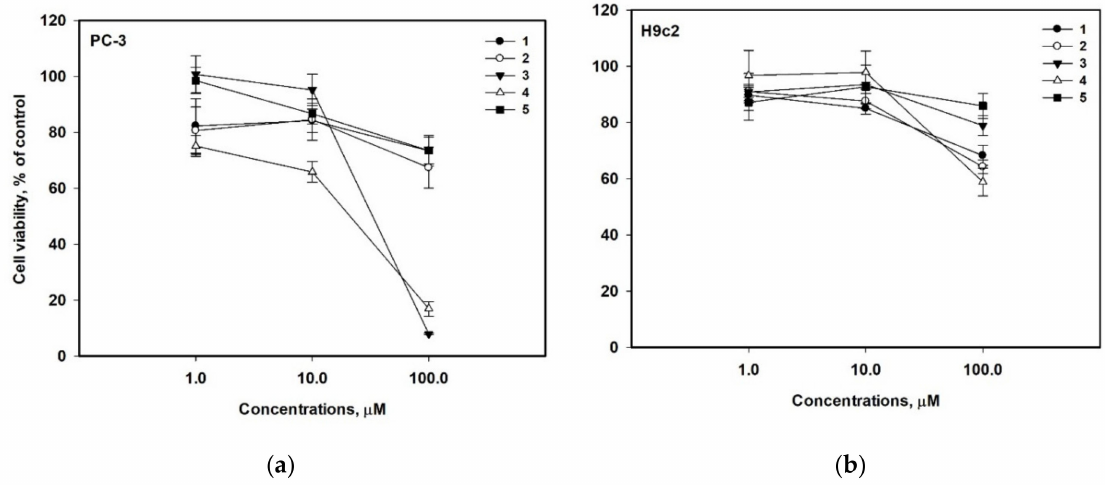
Figure 5. Cytotoxic activity of compounds 1–5 at different concentrations toward PC-3 ( a ) and H9c2 ( b ) cells.